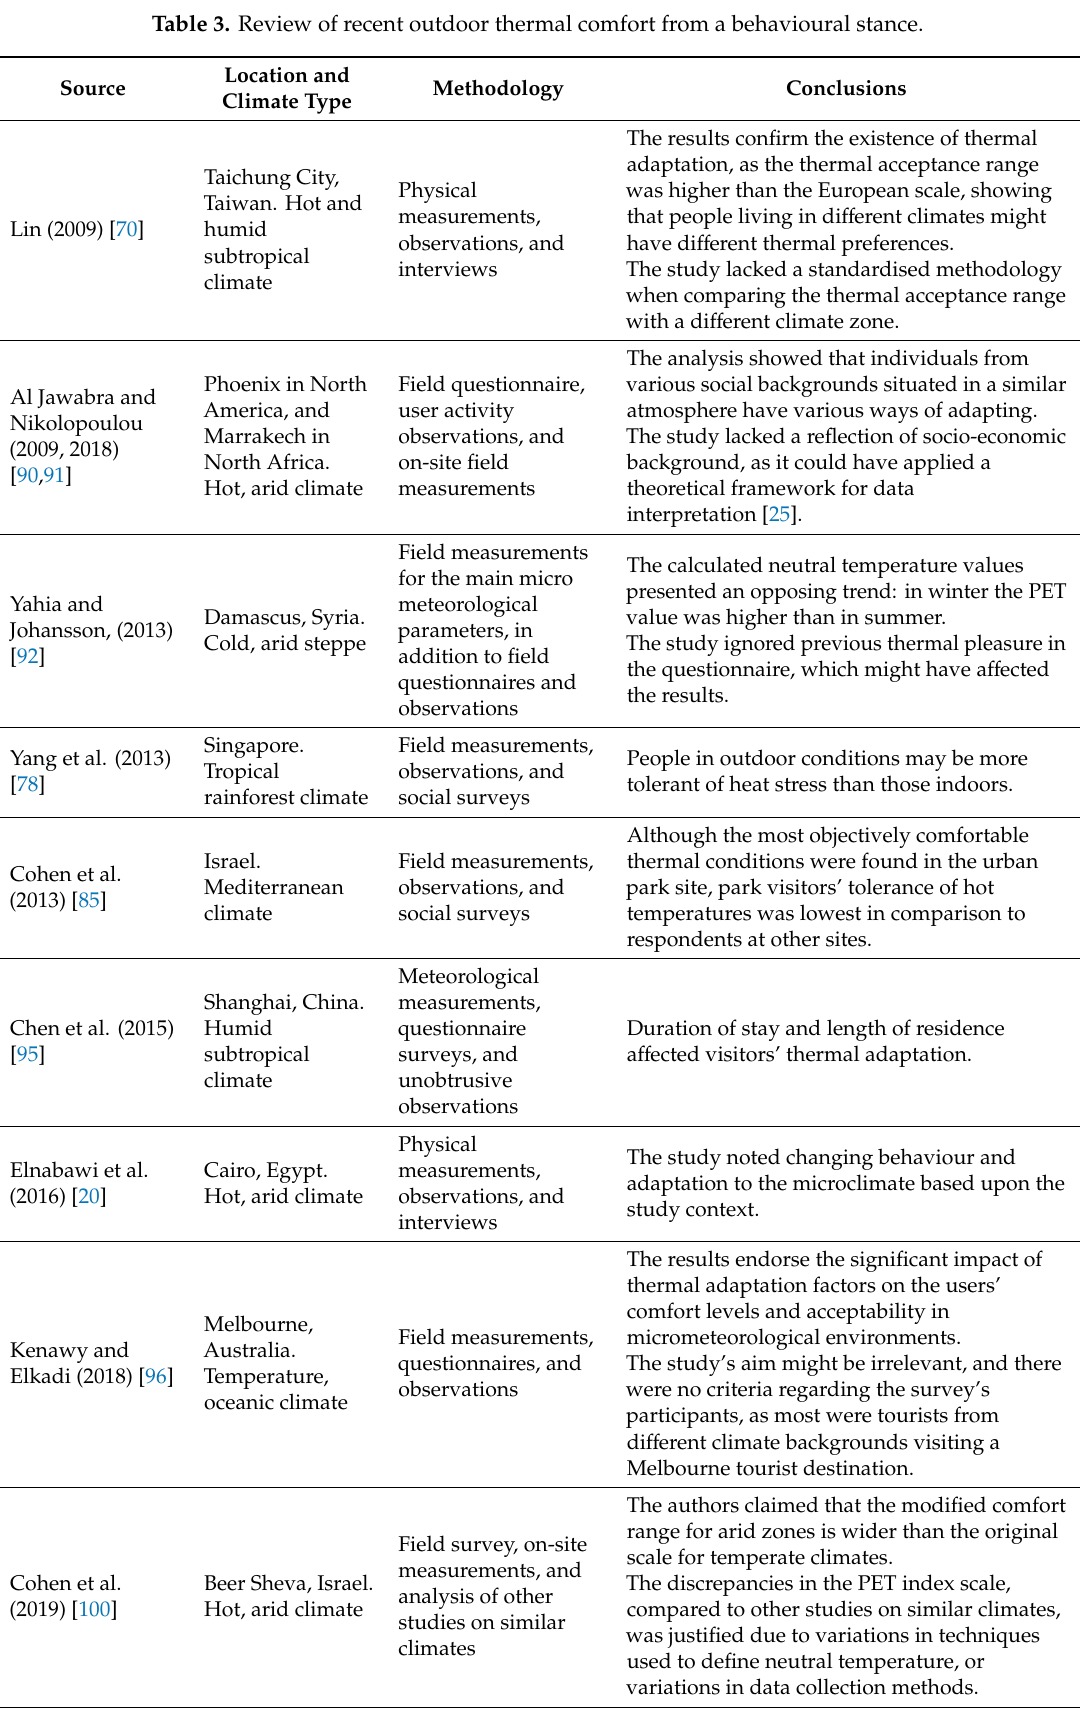
Table 3. Review of recent outdoor thermal comfort from a behavioural